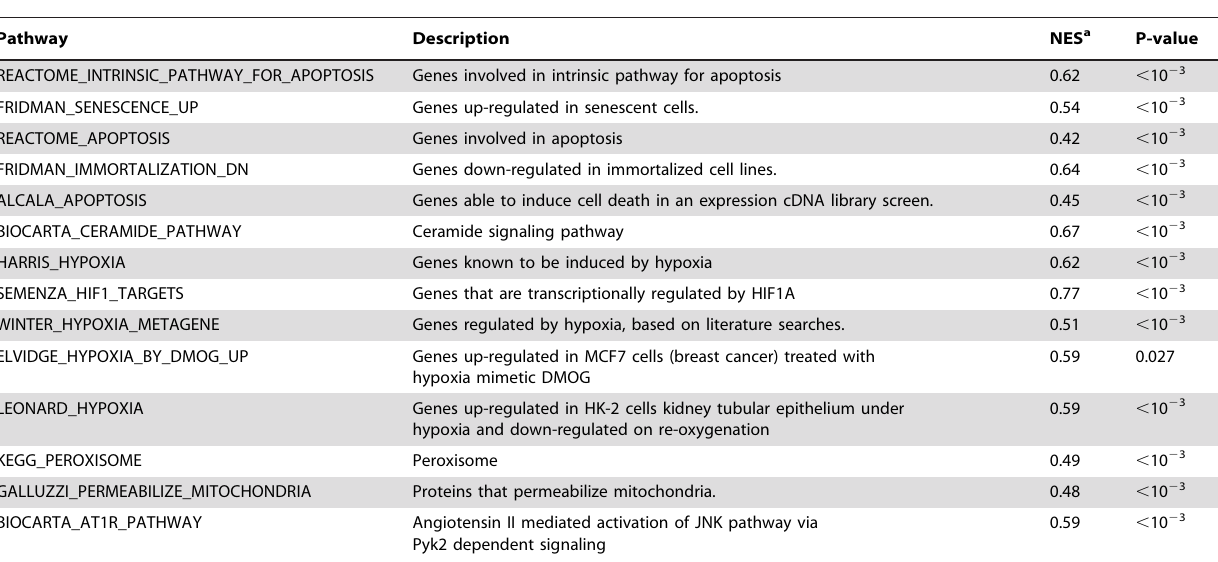
Table 3. Selected pathways significantly up-regulated in KBD vs. control.